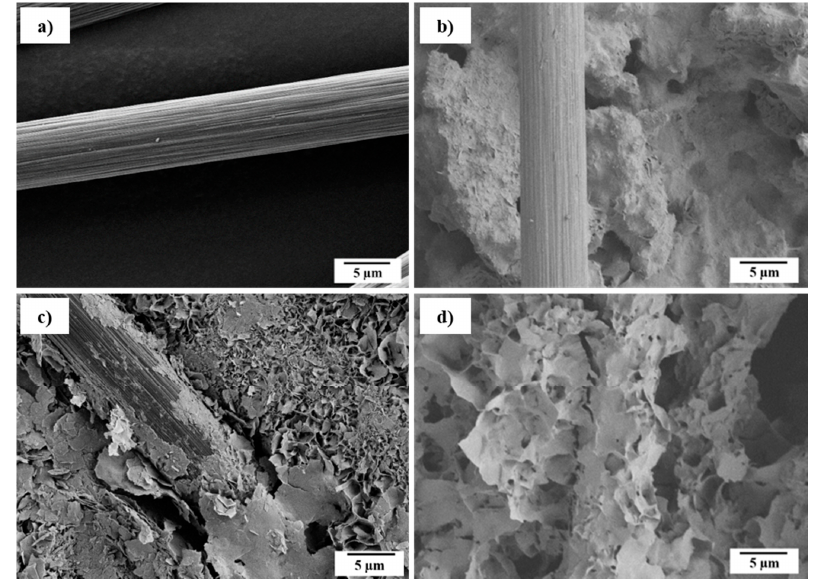
Figure 3. Scanning electron microscopy of ( a ) untreated fibers and in ( b ) cement; as well as ( c ) H 2 O 2 - treated fibers and ( d ) aqua regia and CaCl 2 -treated fibers in